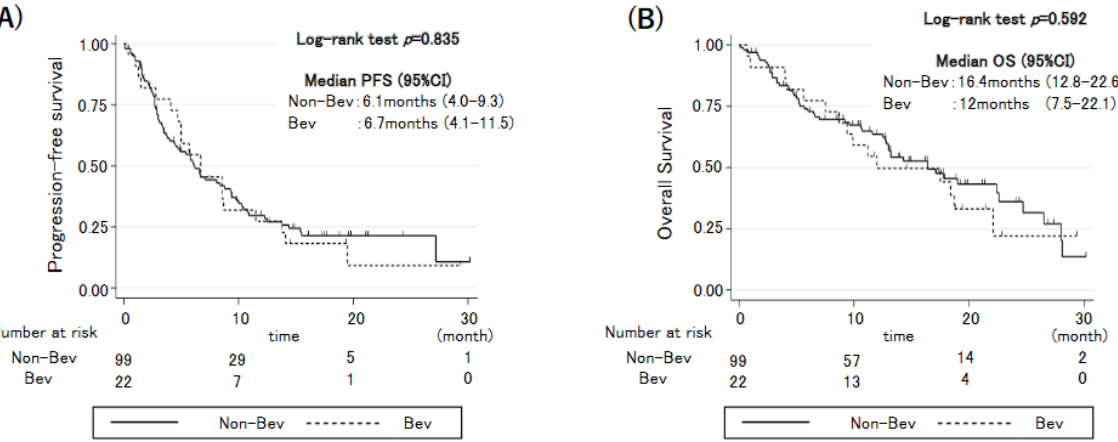
Figure 3. Kaplan-Meier curves for ( A ) progression-free survival and ( B ) overall survival in patients undergoing immunochemotherapy with (Bev) and without (Non-Bev)